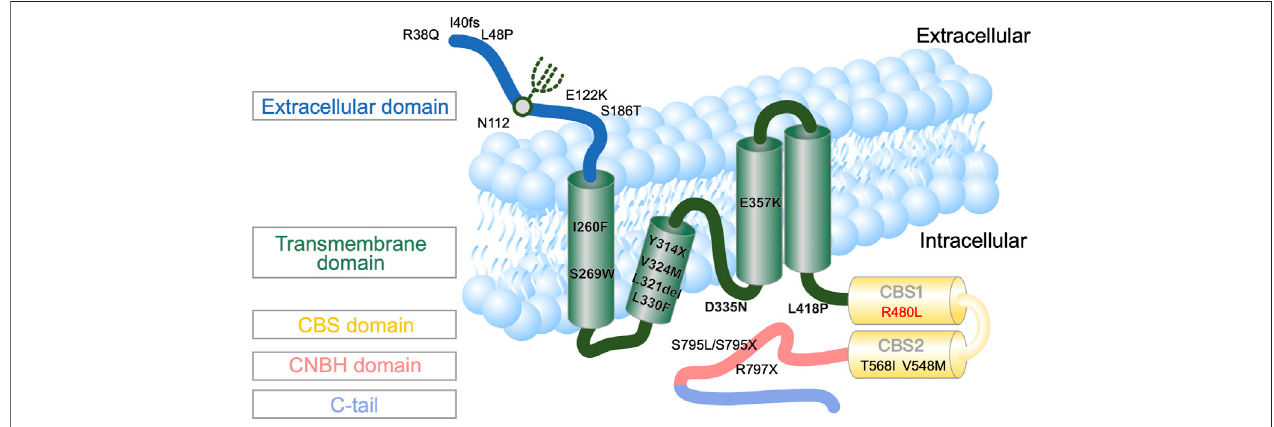
FIGURE1| TopographyofhumanCNNM2withthepositionofthereportedmutations(Stuiveretal.,2011).*indicatesthemutationsiteandlocationinthispatient.